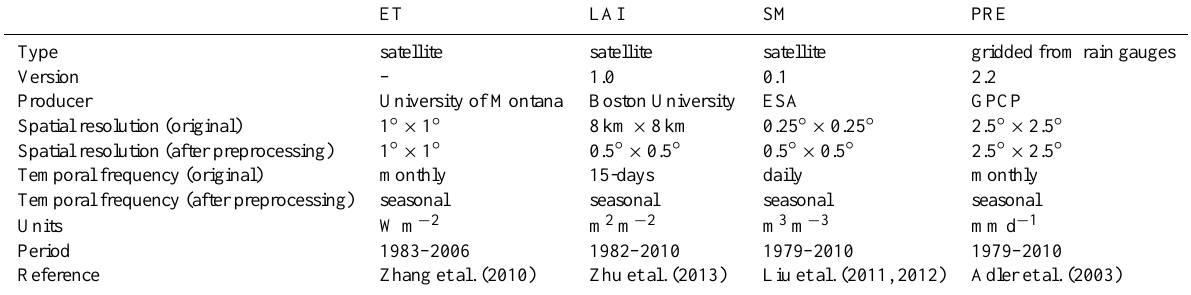
Table 1. Evapotranspiration (ET), leaf area index (LAI), soil moisture (SM), and precipitation (PRE) data set characteristics.